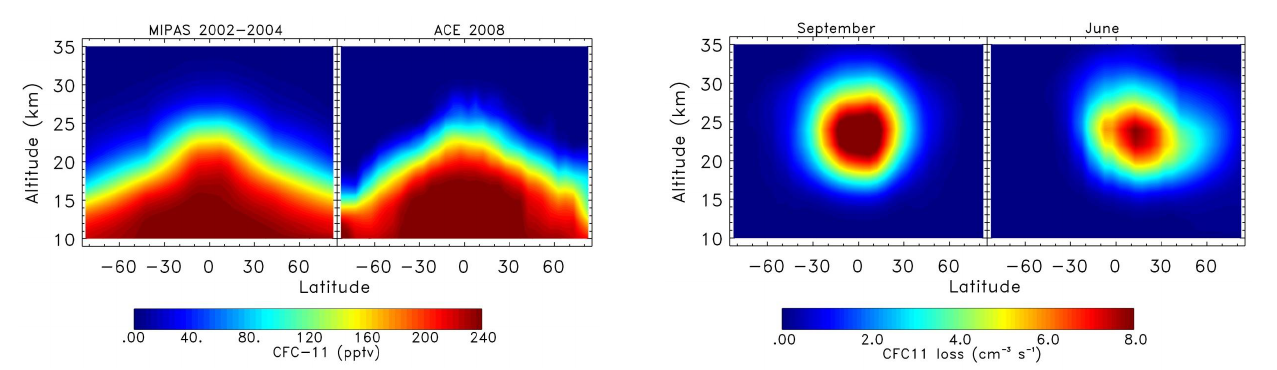
Fig. 3. Zonal mean distributions of CFC-11 from MIPAS averaged over 2002-2004 (left) and from ACE 2008 annual mean (right).